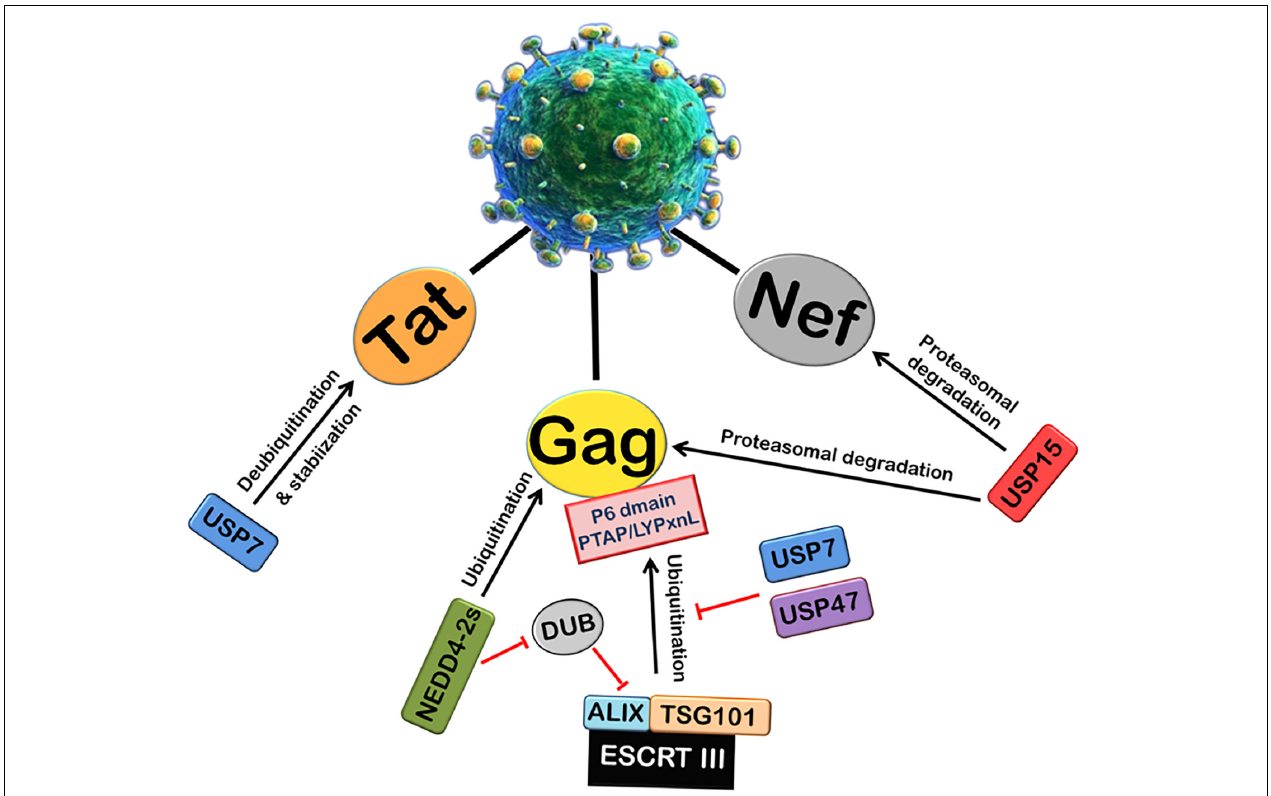
FIGURE 3 | Role of Deubiquitinases (DUBs) in HIV-1 replication. Ubiquitin-Specific Proteases (DUBs) play an important role in viral replication. The ubiquitination and processing of Gag by ESCRT III machinery is inhibited by USP7 and USP47. A deubiquitinase DUB binds ALIX and inhibits the viral release. NEDD4-2s E3 ubiquitin ligase inhibits the action of DUB. USP7 also deubiquitinates and stabilizes HIV-1 Tat protein. In contrast, another deubiquitinase USP15 induces proteasomal degradation of HIV-1 Nef and Gag proteins.